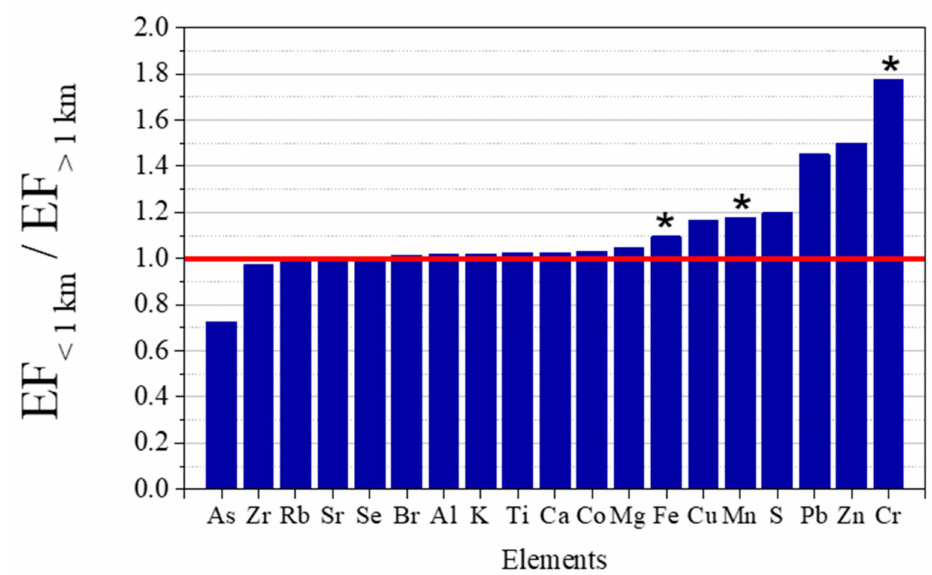
Figure 9. Ratio between EF in samples located at less than and more than 1 km from steelworks. * Significant statistical difference between the EF in the two groups by a Mann-Whitney U test, at 0.05 significance